Question: What style of plot is this figure drawn as?
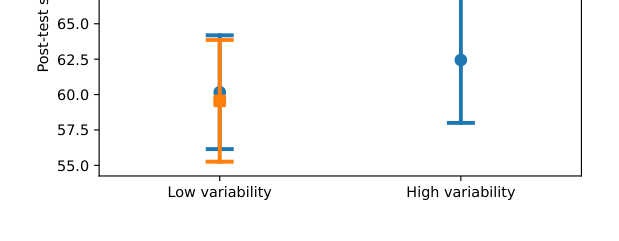
Answer: bar